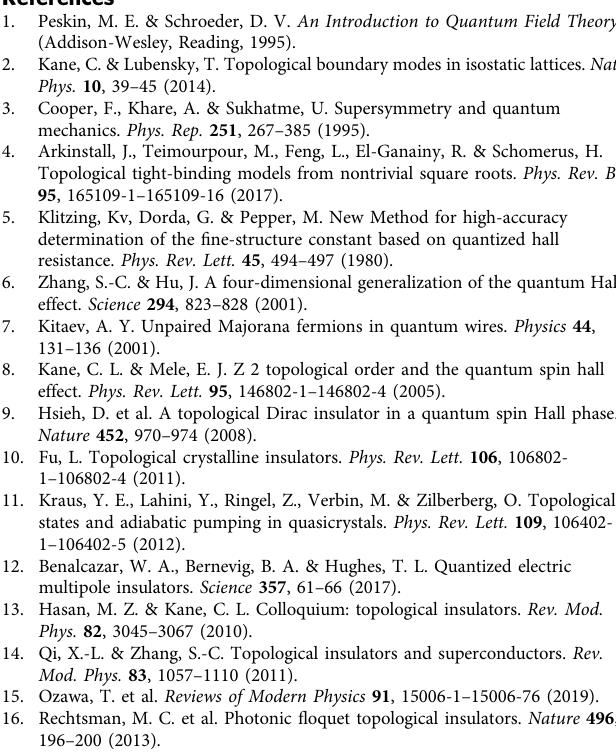
Fig. 5 Boundary dynamics and symmetry protection. a Amplitude distribution of the boundary state with energy E ¼ distribution of the boundary state with energy E ¼ (cid:2) between two boundary states excited by launching light into the outermost waveguide of the structure. The horizontal scale bar corresponds to 1 cm, while the vertical scale bar corresponds to 50 μ m. d Tight-binding simulations con fi rming the